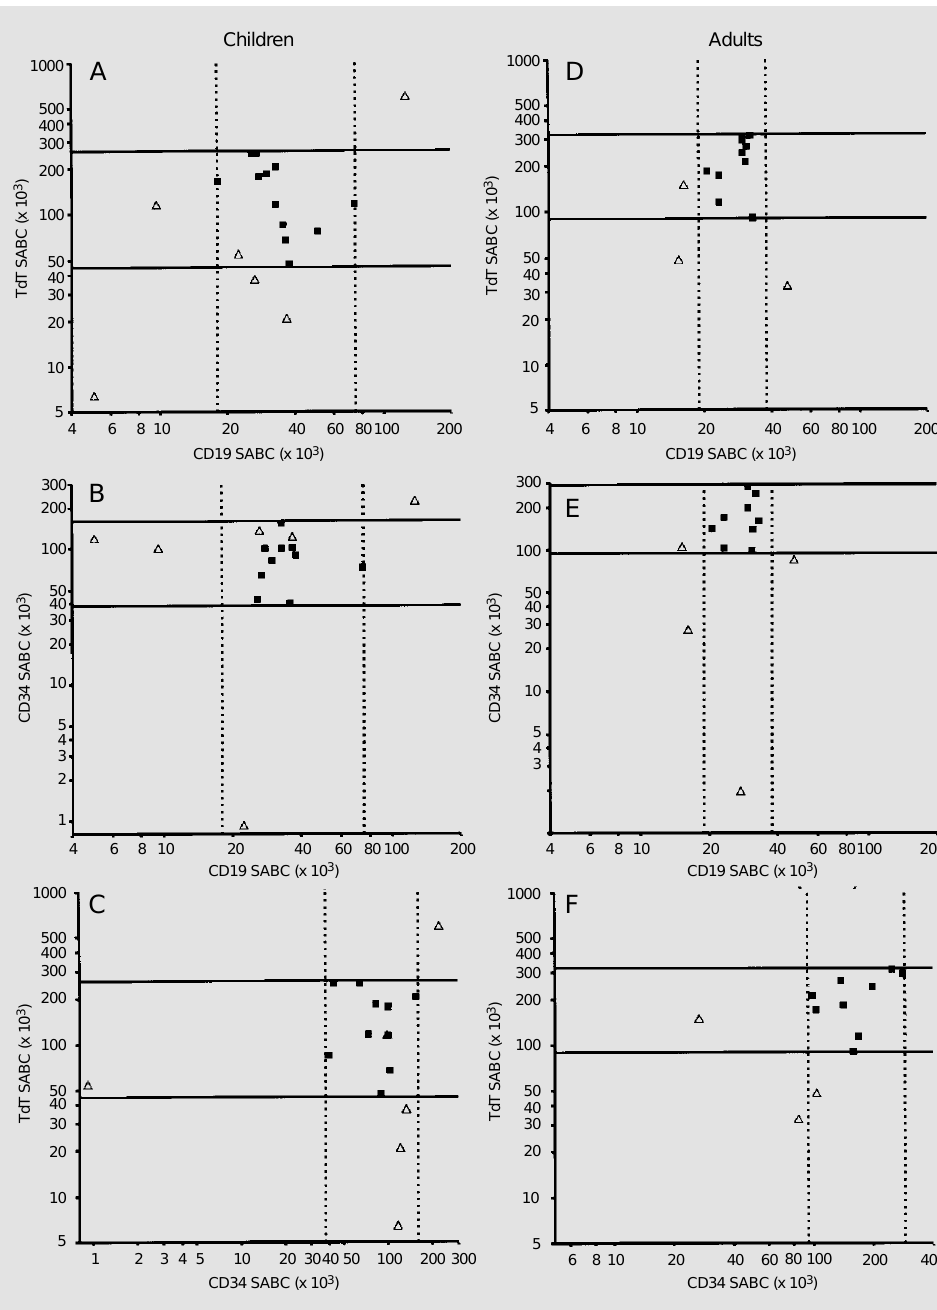
irrelevant and non-lymphoid events (23).